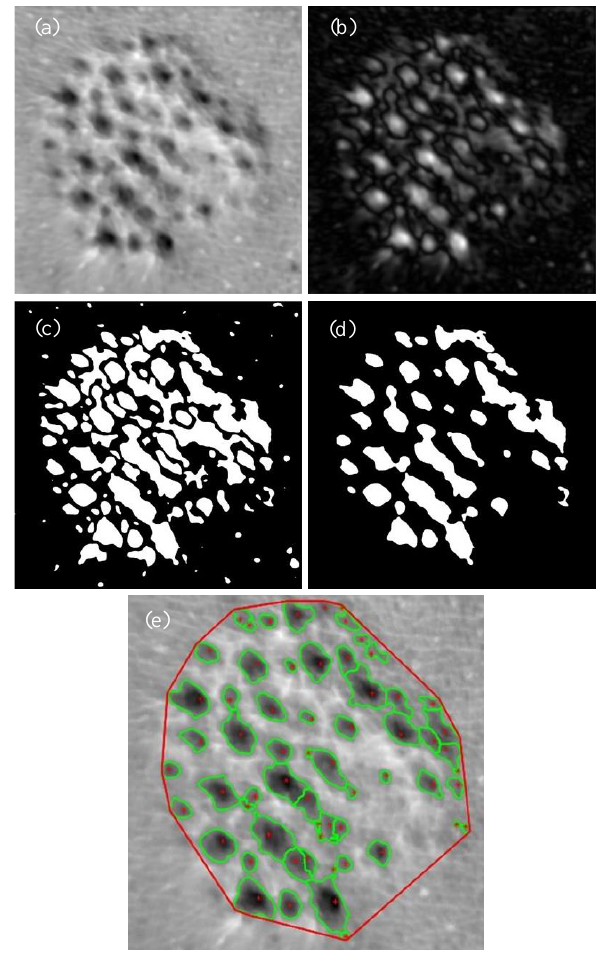
Figure 5. Structure-from-motion result (Screenshots Agisoft PhotoScan) – point cloud with 8.5 million points